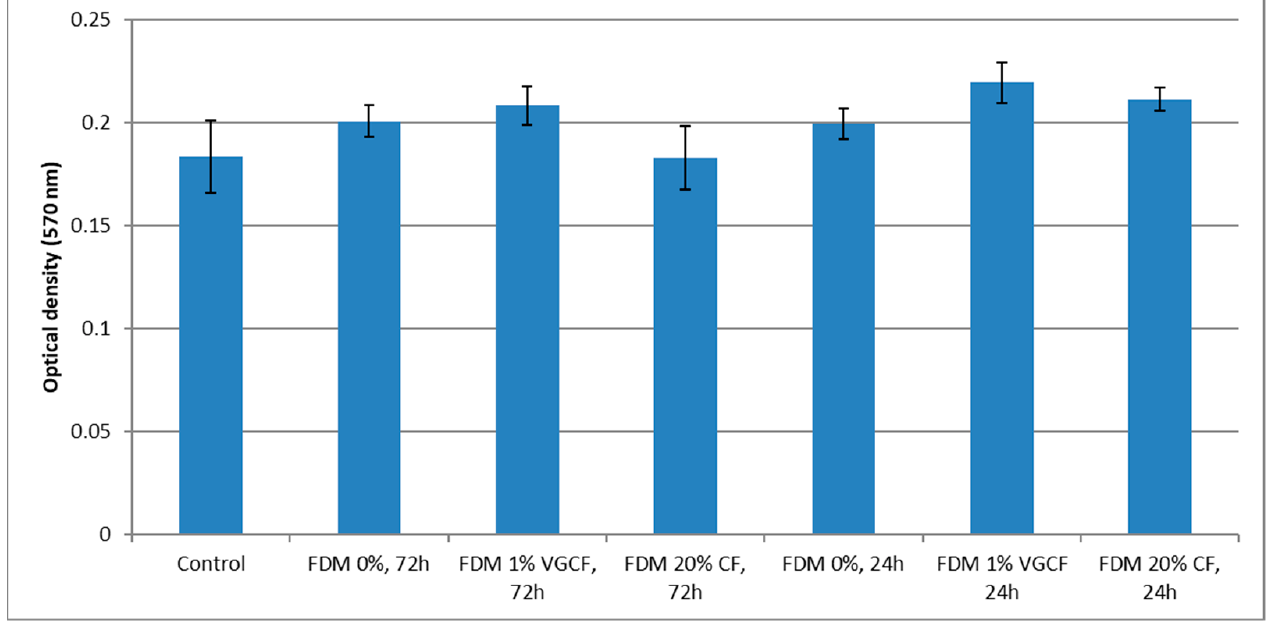
Figure 9. Comparative characteristics of the optical density of formazane solutions obtained from the studied samples.